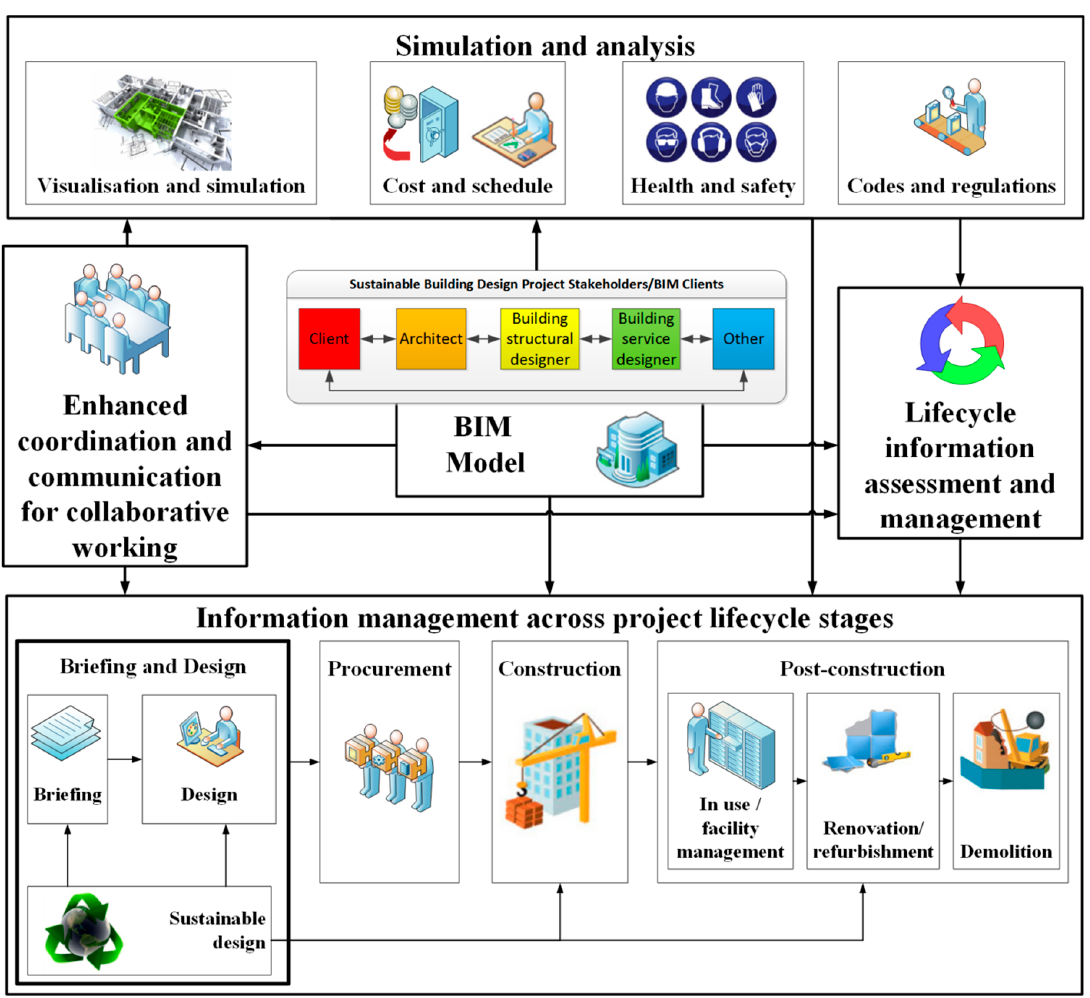
Figure 1. The user level driven Building Information Management (BIM) for sustainable design information management (devised by the authors based on the literature).